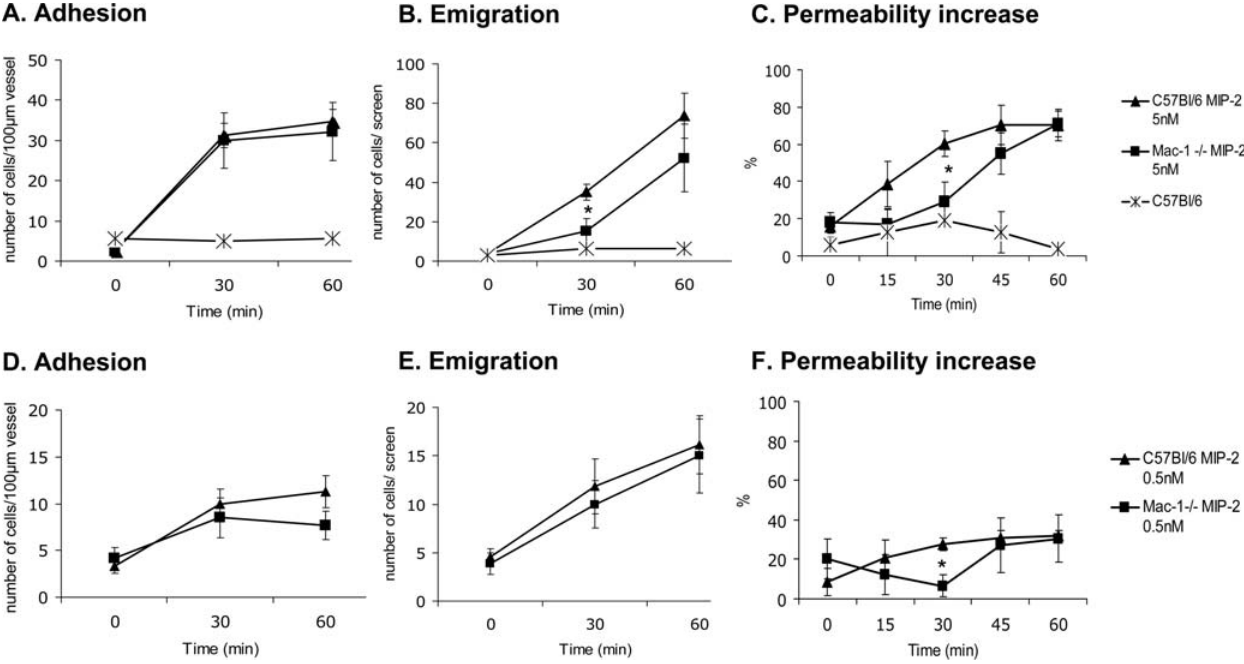
Figure 1. Leukocyte recruitment and vascular permeability, 5 nmol/L MIP-2 (A–C) and 0.5 nmol/L MIP-2 (D–F) superfusion. Leukocyte adhesion (A and D), emigration (B and E) and microvascular permeability increase (C and F) before (time 0) and after addition of MIP-2 (5 nmol/L in A– C and 0.5 nmol/L in D–F) in the superfusate in WT (n=5 for each concentration) and Mac-1-/- mice (n=5 for each concentration). Untreated wild-type mice (n=5) are also included. A leukocyte was considered to be adherent if it remained stationary for more than 30 s, and was quantified as the number of adherent cells within a 100 m m length of venule during 5 min. Leukocyte migration was defined as the number of cells in the extra vascular space within a 200 6 300 m m area. All values are means 6 SE. * p , 0.05 compared to C57Bl/6 mice receiving similar treatment at the same time-point.